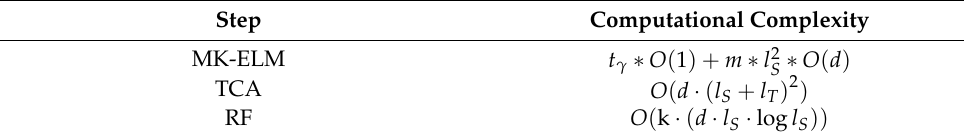
Table 7. The computational complexity of each step.